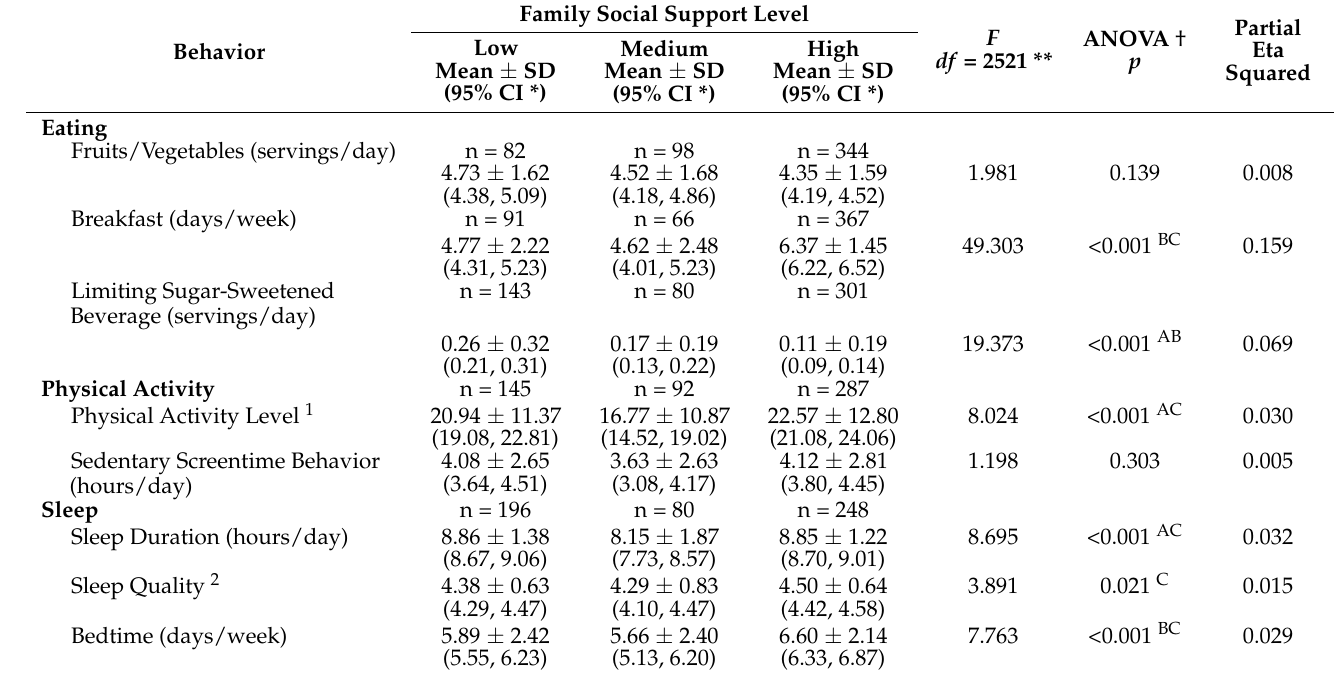
Table 3. Relationships among family social support for children’s weight-related behaviors (N =